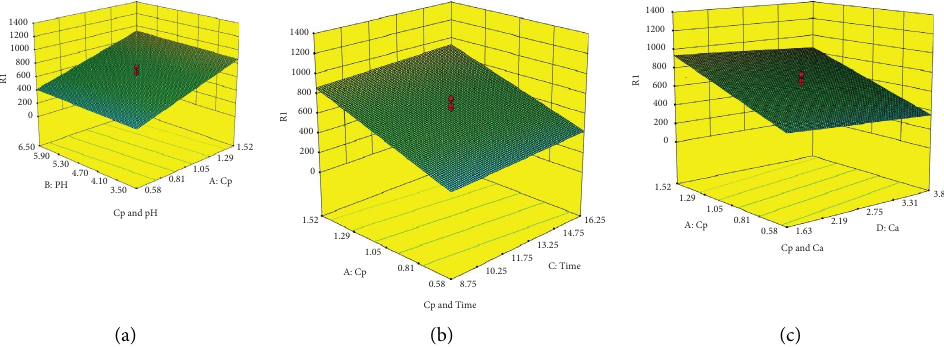
Figure 9: Simultaneous efects of initial concentration of Pb (II) and pH (a), initial concentration of Pb (II) and adsorbent concentration on Pb (II) removal rate (b) and, initial concentration of Pb (II) and contact time (c). Table 2: Parameter isotherms of adsorption for the Langmuir and Freundlich-TWMNPs. Isotherms Isotherm equations Fixed coefcients and correlation coefcients of isotherms Langmuir